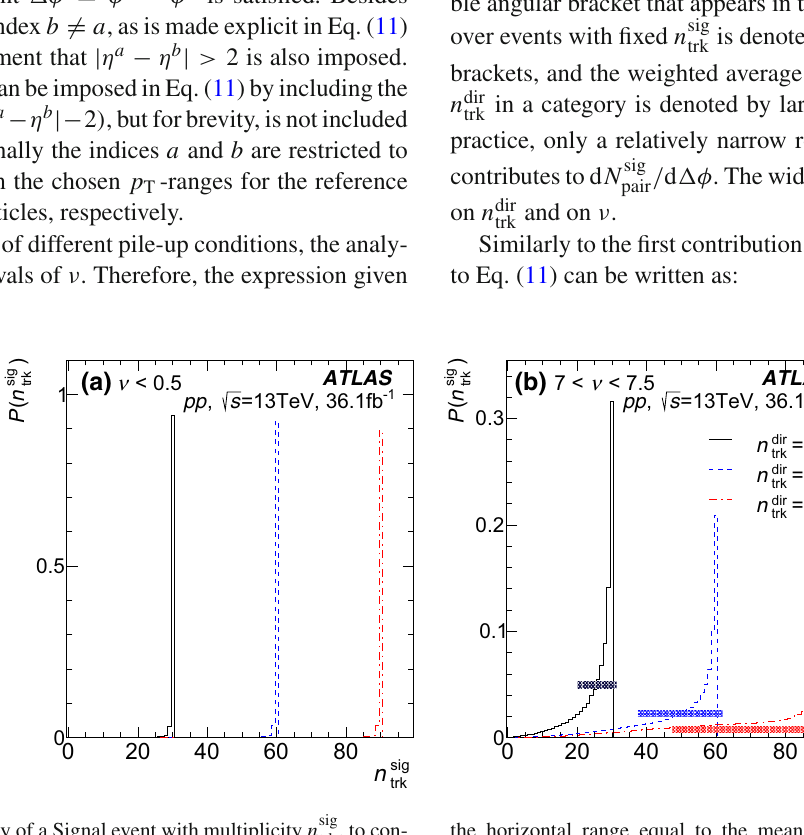
, to con- the horizontal range equal to the mean ± RMS value of the his- trk = 30, 60 and 90 (solid, dashed, togram with the corresponding colour. a ν < 0 . 5 and b for 7 < ν < trk 7 . . The shaded bands denote trk